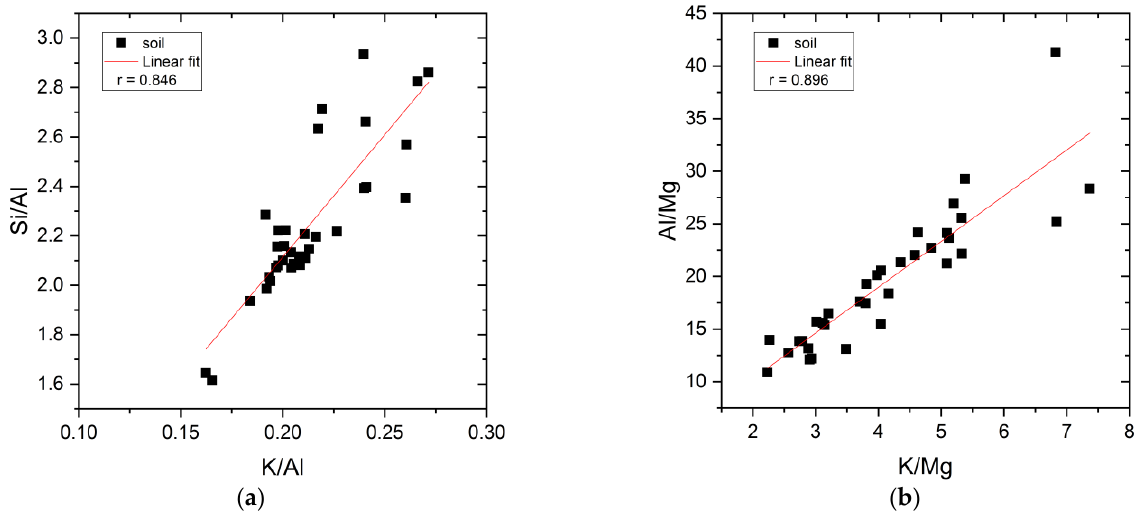
Figure 4. ( a ) K/Al:Si/Al molar ratio correlations ( b ) K/Mg:Al/Mg molar ratio correlation.